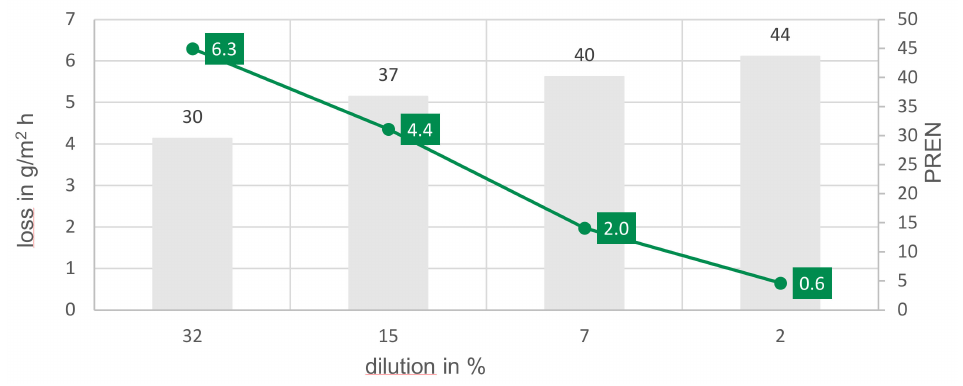
Figure 29. Loss over dilution for different building strategies [52].